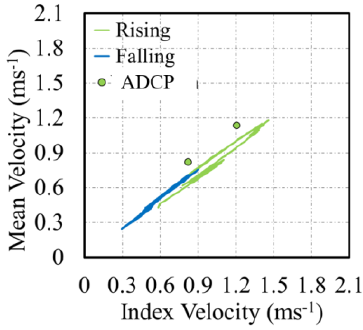
Figure 12. ADCP-derived data compared with IVRC rating for Pulses 20–21 of the WY 2015.